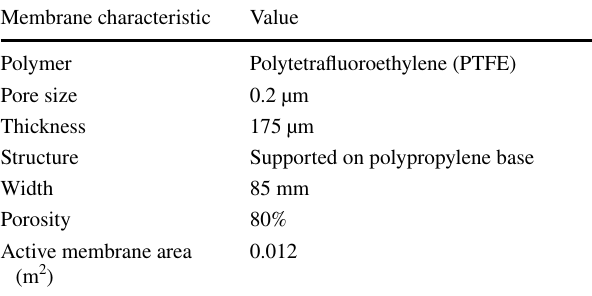
Table 2 Properties of PTFE flat sheet membrane